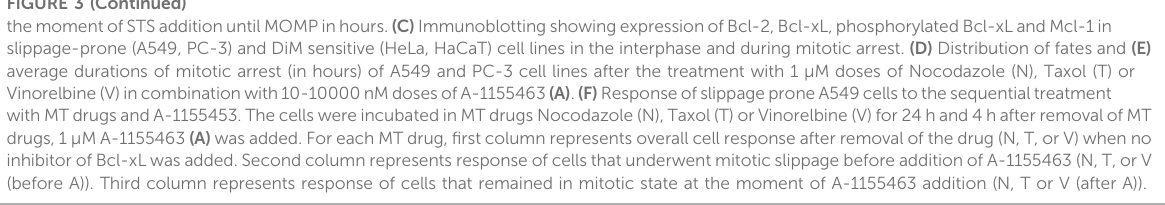
Figure S1). Distribution of cell fates within each cell line (intra- line variation) remained highly conservative for all doses above the T2 level of all three drugs (Figures 2B,C; Supplementary Figure S1). To assess dose-dependent intra-line variation in detail, we analyzed A549 and U-118 cells, which showed all three fates following mitotic arrest at relatively high